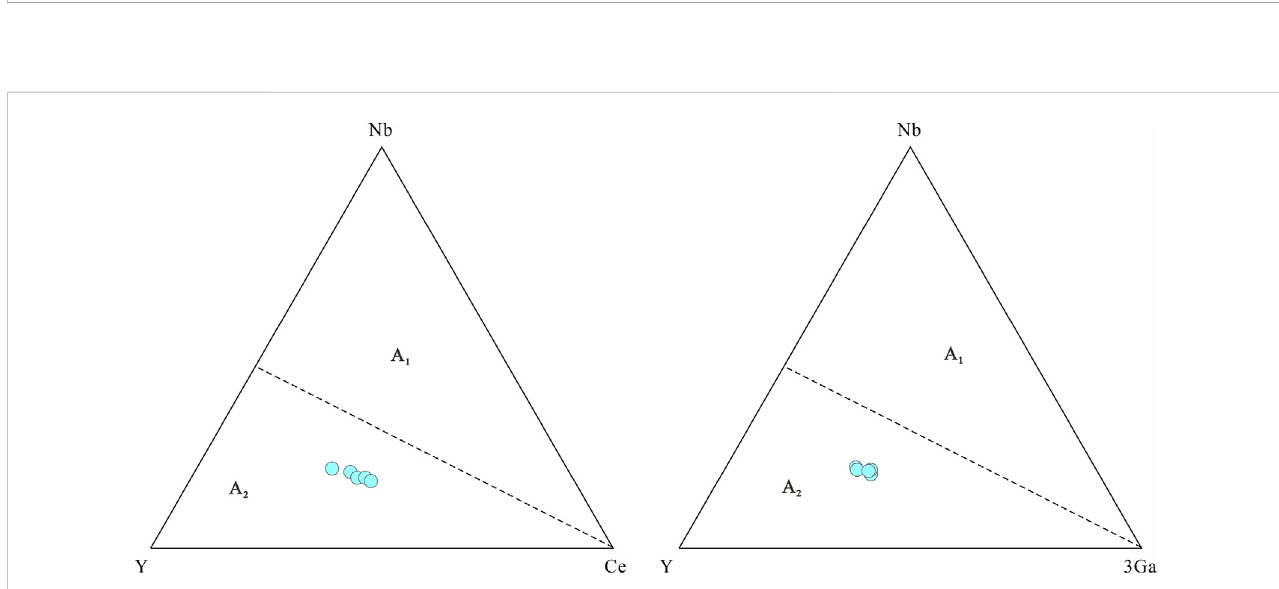
FIGURE 12 Nb − Y − Ce and Nb − Y − 3Ga triangle diagrams for distinguishing A 1 and A 2 granites (Eby, 1992).